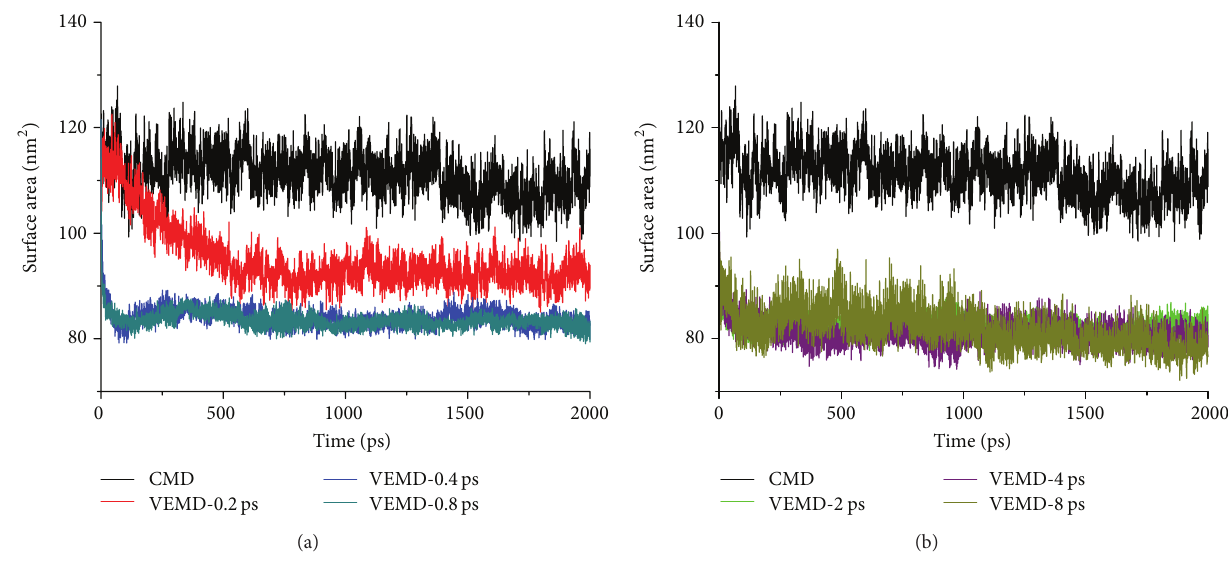
Figure 3: The surface area curves of the polyethylene molecule during the CMD simulation (shown in black) and six VEMD simulations with different vibration periods (shown in